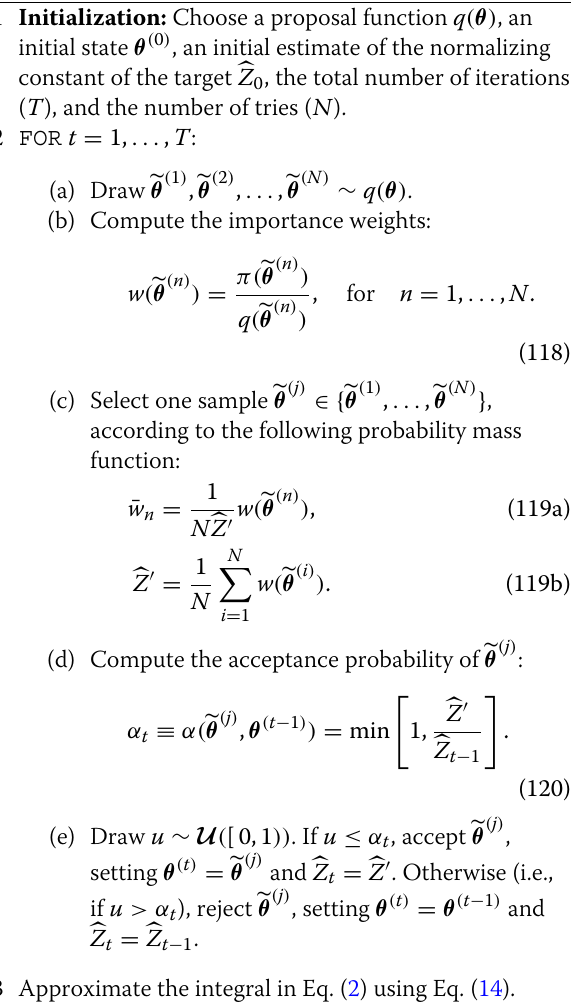
Algorithm 23 Alternative version of I-MTM method (I- MTM2)